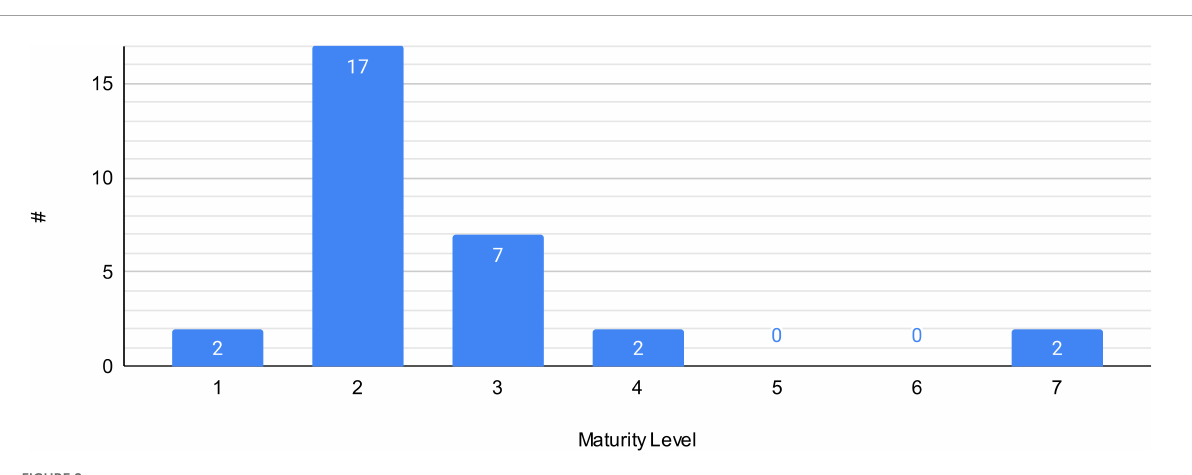
FIGURE8 Bar chart – maturity